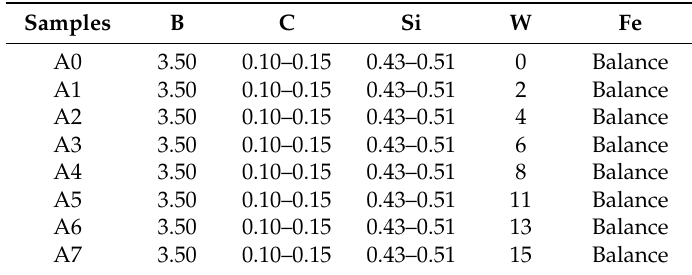
Table 1. The nominal chemical composition of Fe-3.5B alloys (wt